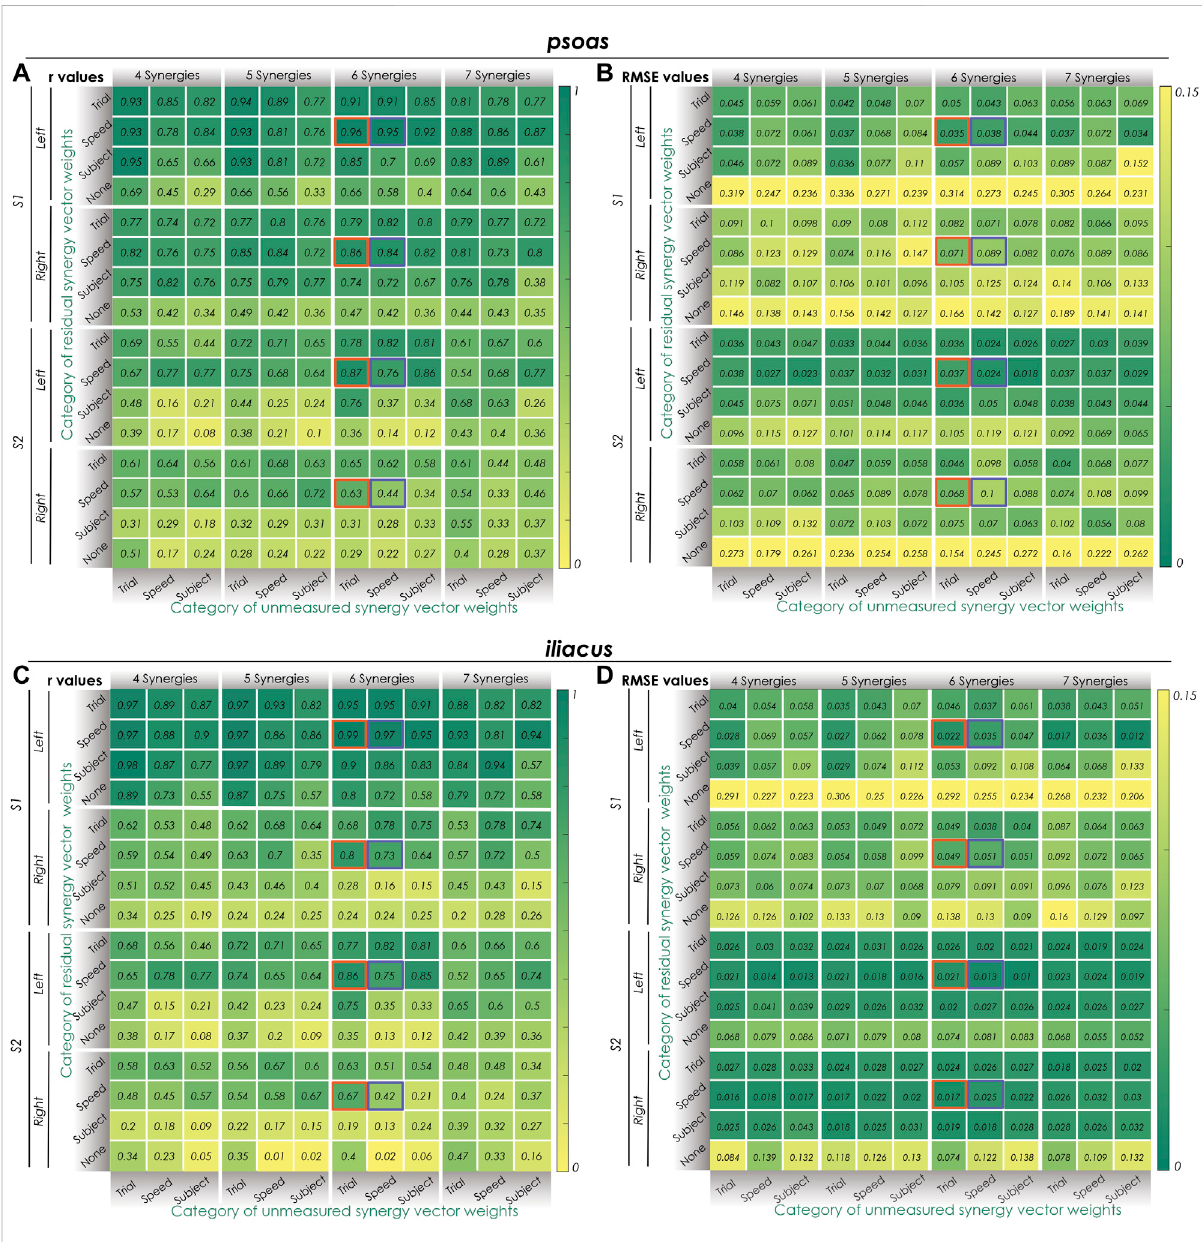
third stage for the “ validation ” situation were described in Third stage: Evaluation of “ validation ” situation of the results.